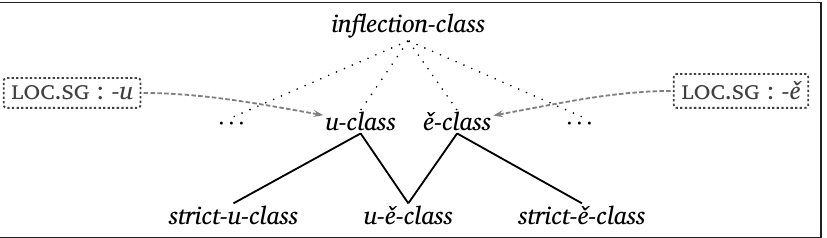
Figure 6 Overabundant classes as meets in an inflection class hierarchy (Guzmán Naranjo 2019; Beniamine